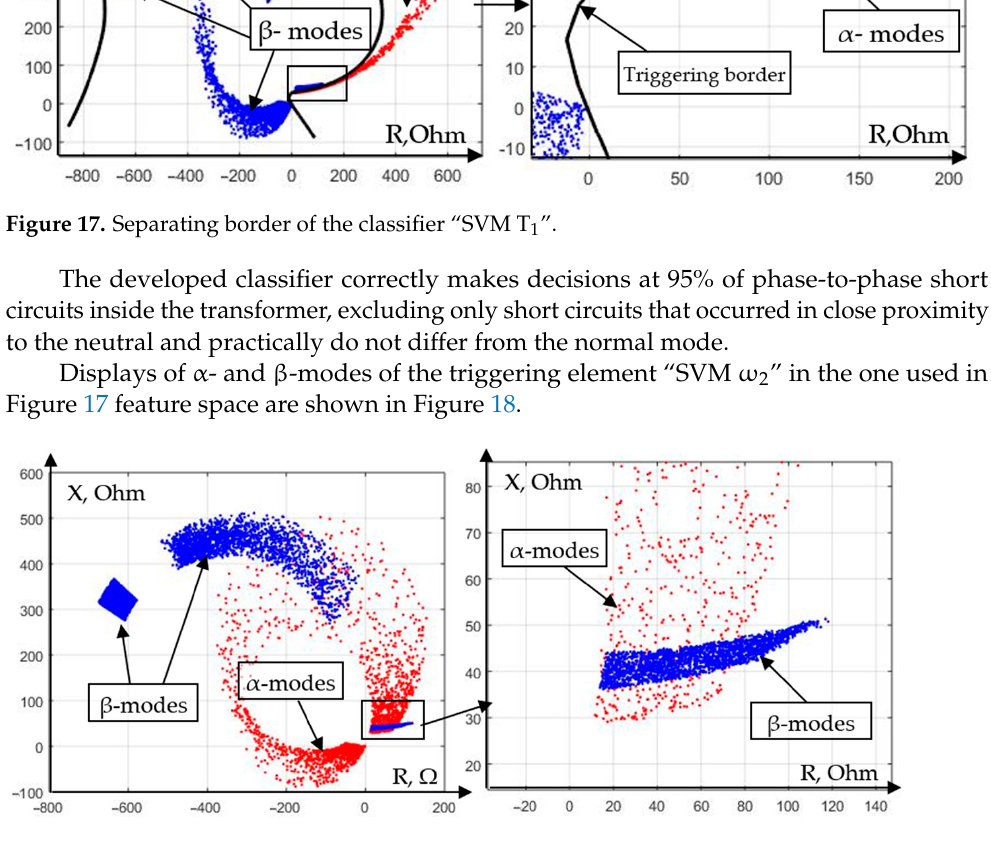
Figure 19. The separating border of the classifier “SVM ω 2 ” in the three-dimensional feature space. Figure 20. The separating border of the classifier “SVM ω 3 ”: ( a ) Using the linear kernel function; ( b ) using the polynomial kernel function ( p = 2). The case (Figure 20) is the most “simple” in terms of recognition of emergency modes, because error-free classification is possible in the space of features of dimension 2 with a